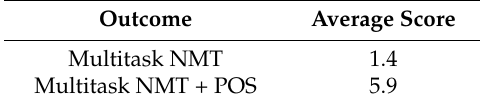
Table 5. Human evaluation scores—Pilot rating experiment for MA-MSA. Table 4. Human evaluation scores—Pilot rating experiment for LA-MSA.